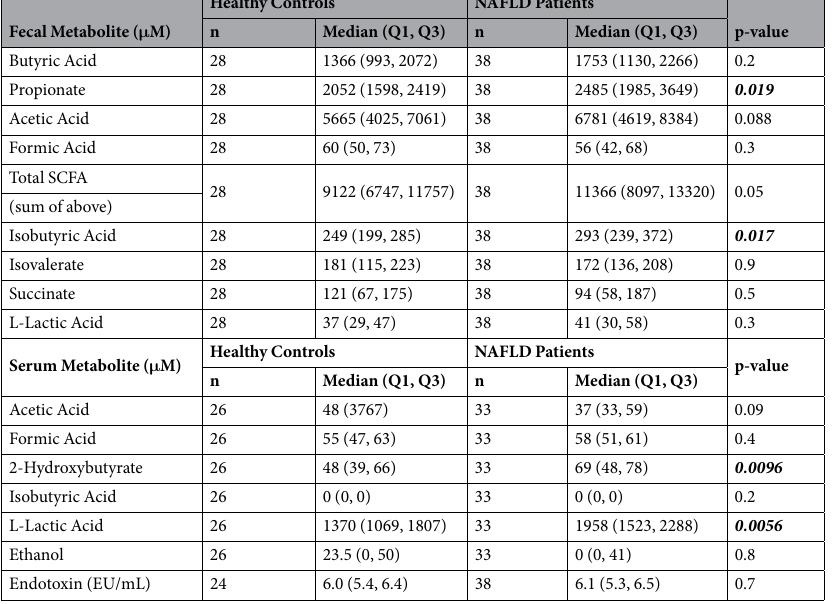
Table 5. Bacteria-related fecal and serum metabolites. NAFLD: nonalcoholic fatty liver disease = patients with simple steatosis and those with nonalcoholic steatohepatitis combined, SCFA: short-chain fatty